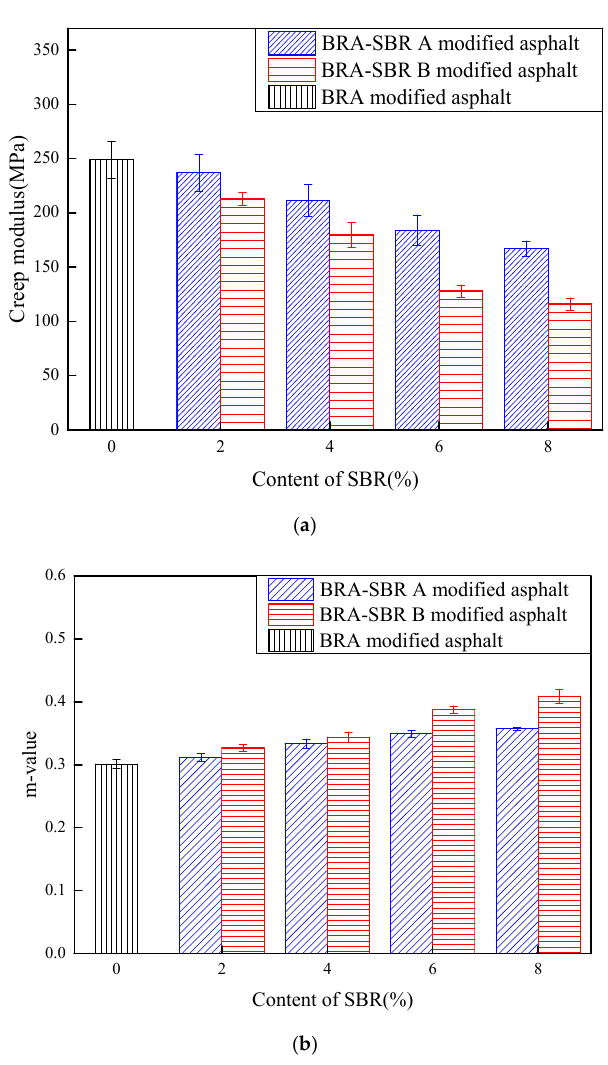
◦ C. ( a ) Creep modulus; ( b )